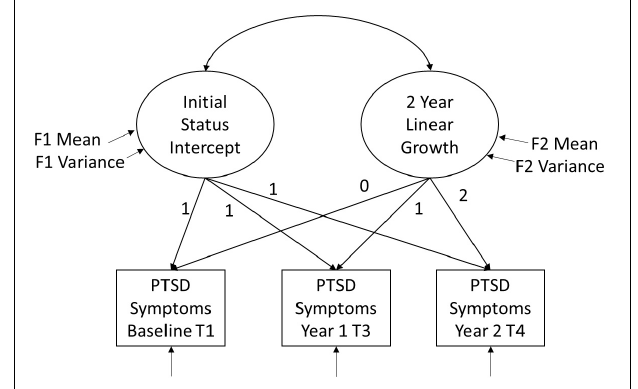
FIGURE 2 | Specification of unconditional latent growth model for PTSD symptoms over 2